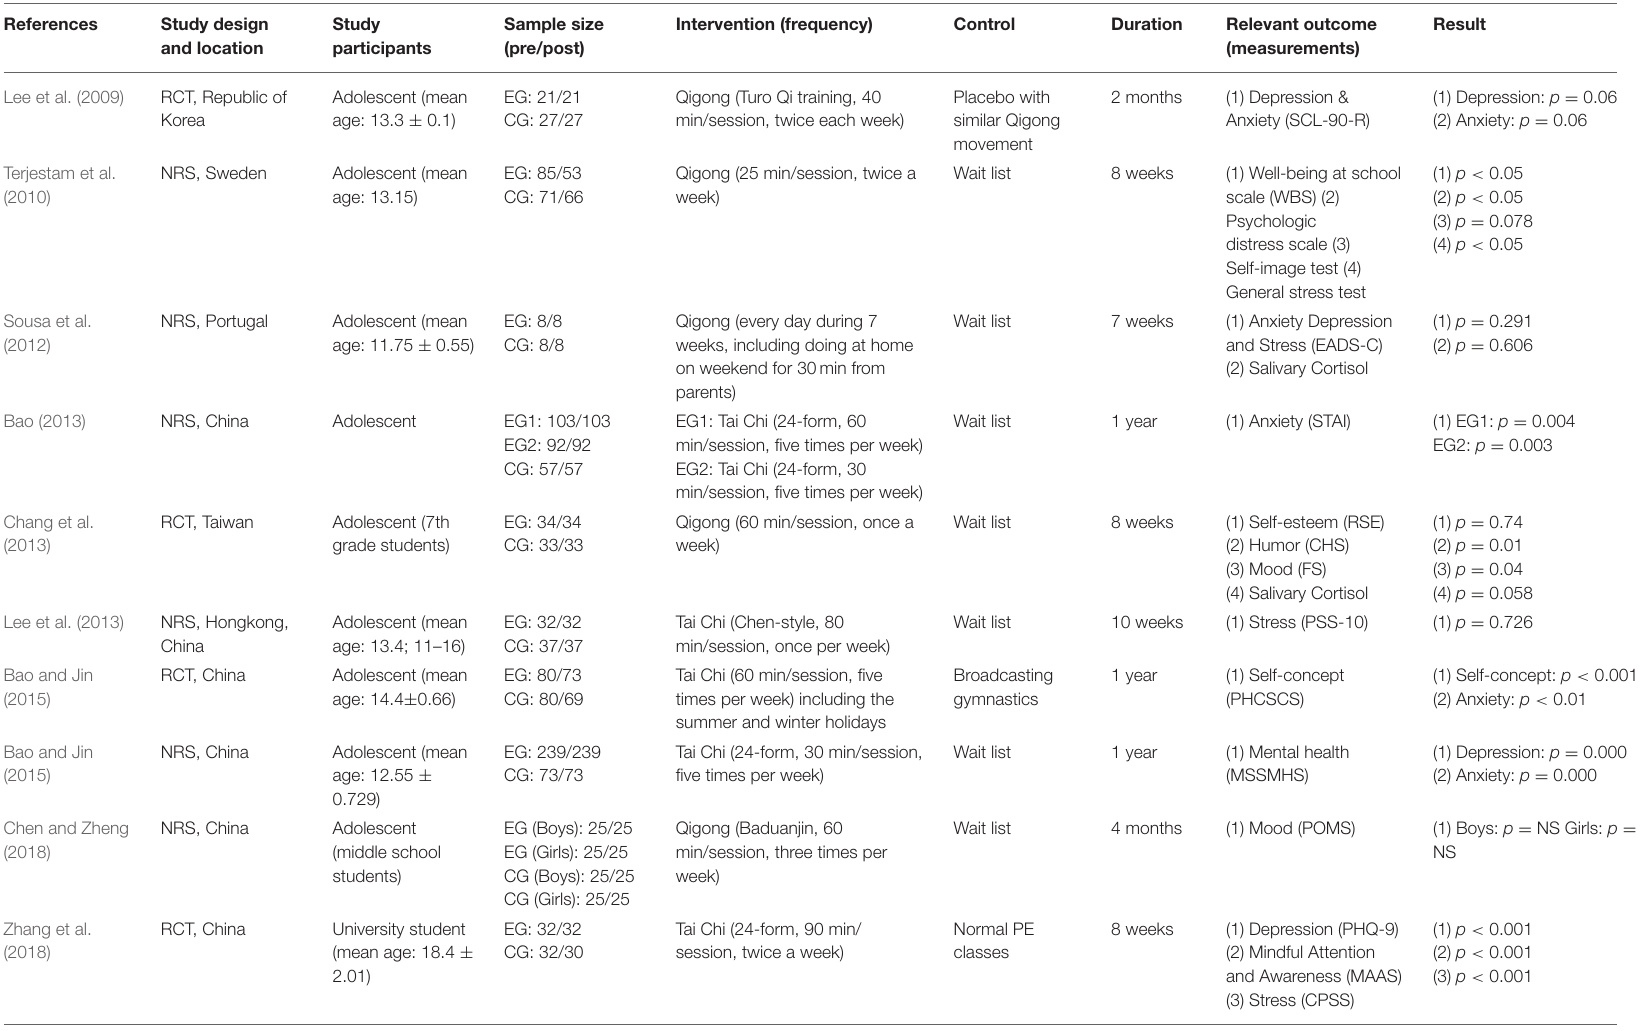
TABLE 2 | Characteristics of included study ( n =